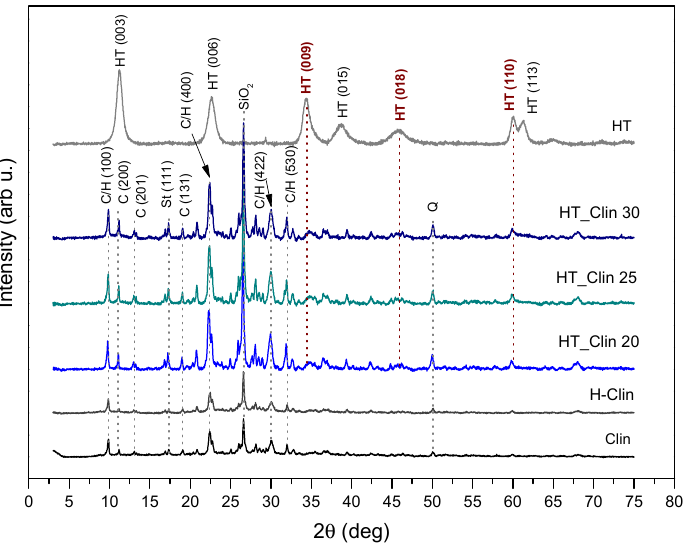
Figure 3. XRD diffractograms obtained for the samples.